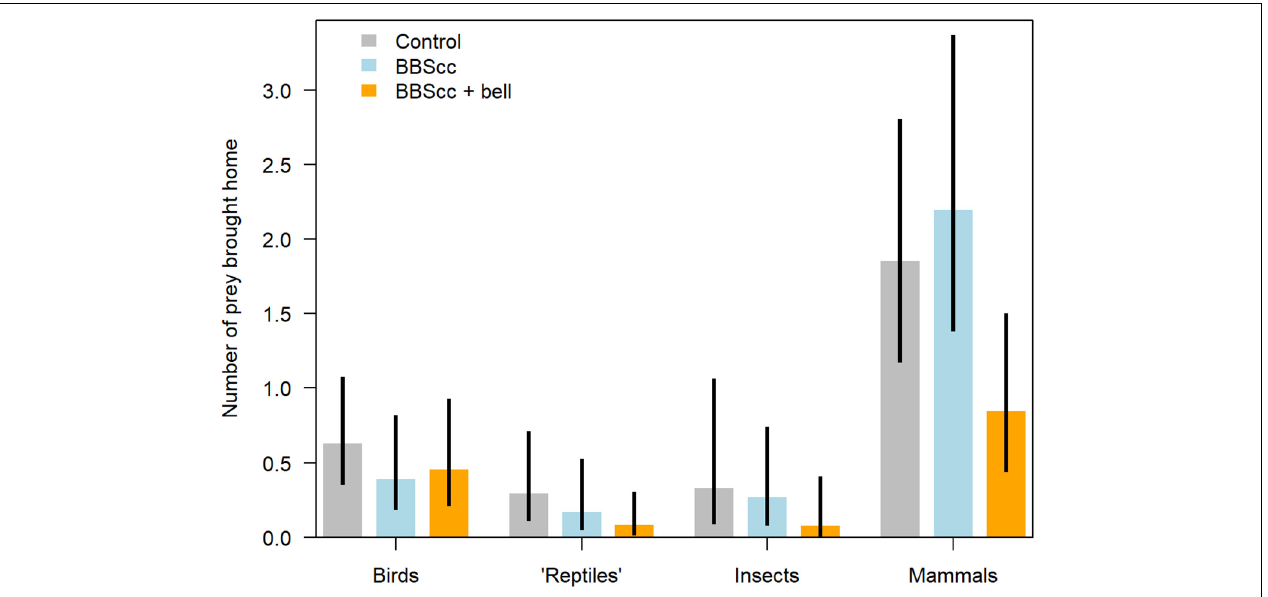
FIGURE 2 | Expected number of prey brought home per household in each 2-week treatment phase and separated per prey taxon (birds, “reptiles” insects, and mammals). Lower and upper limits of the 95% uncertainty interval are indicated with vertical black bars [equals “credible interval” or “confidence interval”; Gelman and Greenland (2019)]. BBScc = wearing a Birdsbesafe collar-cover (BBScc) during treatment 1; BBScc + bell = wearing a BBScc and a bell during treatment 2; control = wearing neither BBScc nor bell.